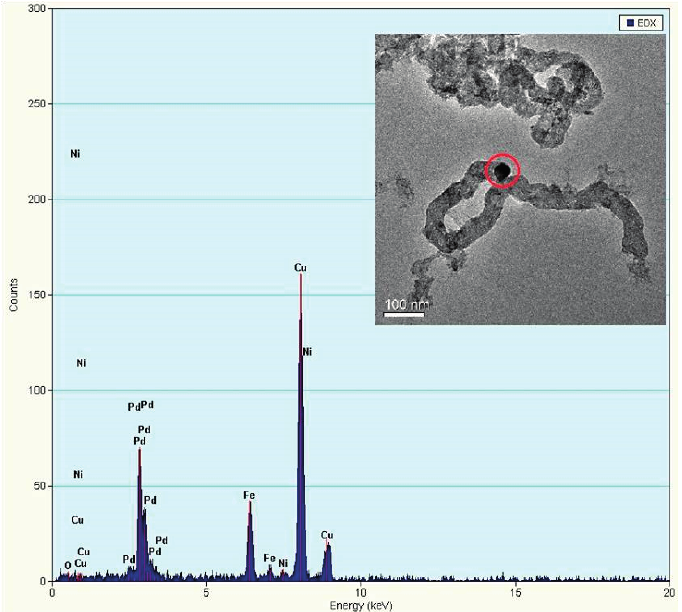
Figure 7. TEM image of CNCs (inset) and EDX spectrum taken within the red circle, which contained one Pd catalyst particle.